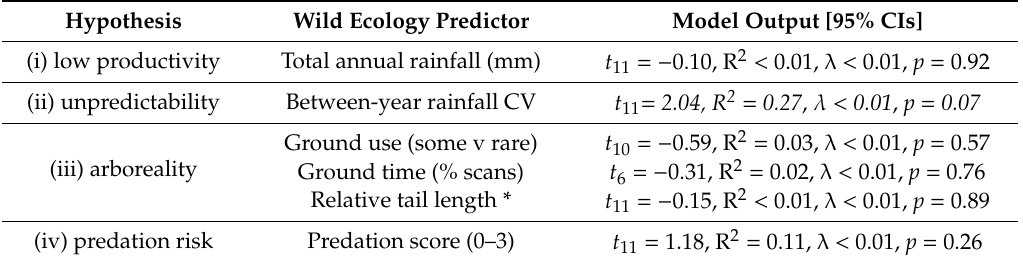
Table 4. Results of hypothesis-testing model results performed over a tree block of 1000 alternative Lemuriform phylogenetic trees. Because values for upper and lower 95% confidence intervals were identical to medians in all cases, here we provide median values for each parameter. CV = coe ffi cient of variation. Results were considered significant at p < 0.05, and trends ( p < 0.10) are italicised. All p values are two-tailed.